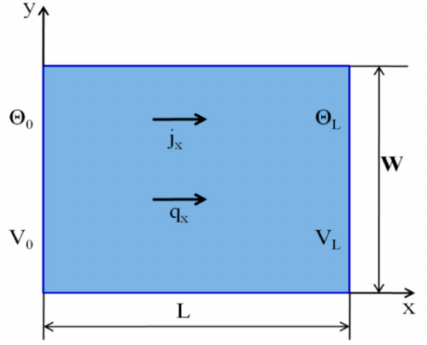
Figure 5. Geometric Parameters and boundary condition for thermoelectric element.